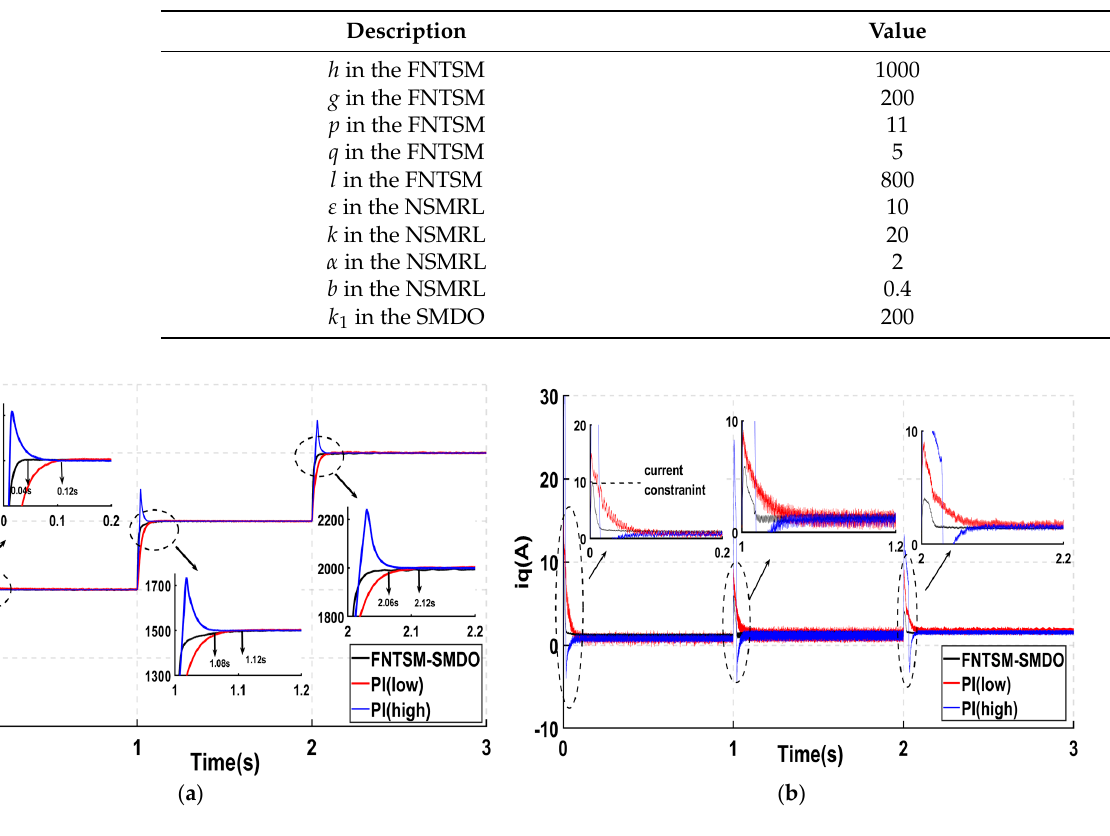
Figure 4. ( a ) Speed curve during variable acceleration start; ( b ) Variable–acceleration start–process q -axis current curve. q -axis current